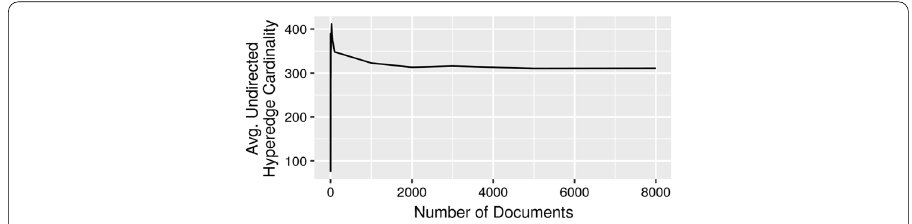
Fig. 4 Average hyperedge cardinality over time for the base model